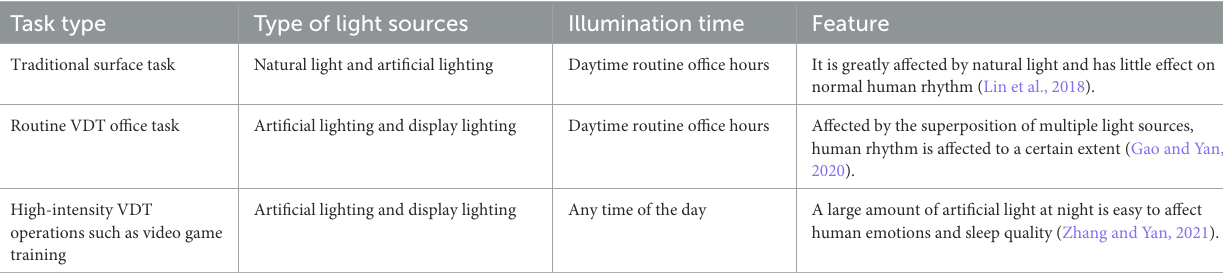
TABLE 4 Light moment characteristics of various types of